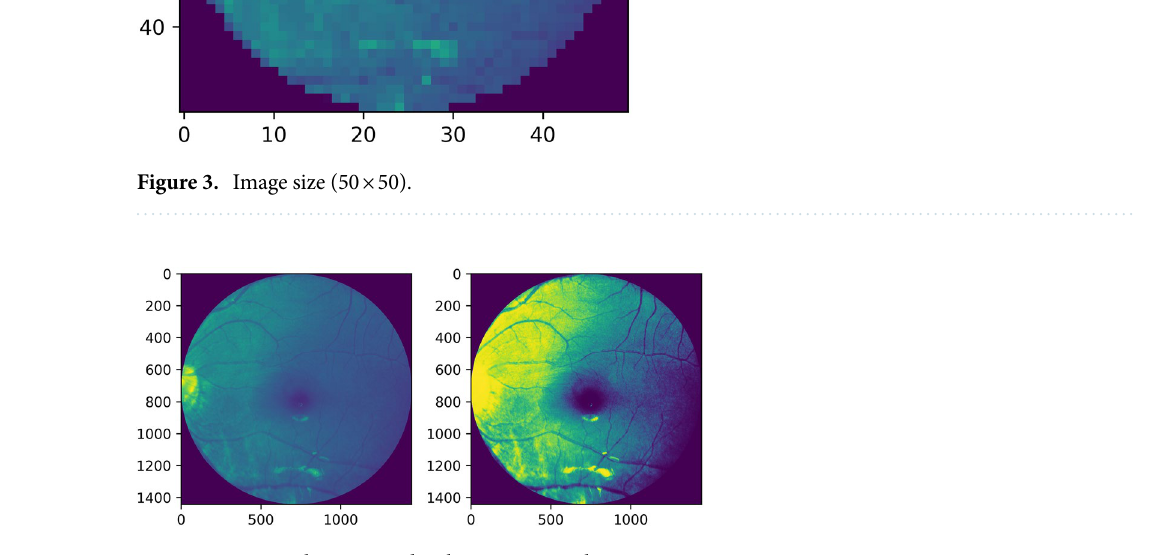
Figure 4. Grayscale image and its histogram equalization.